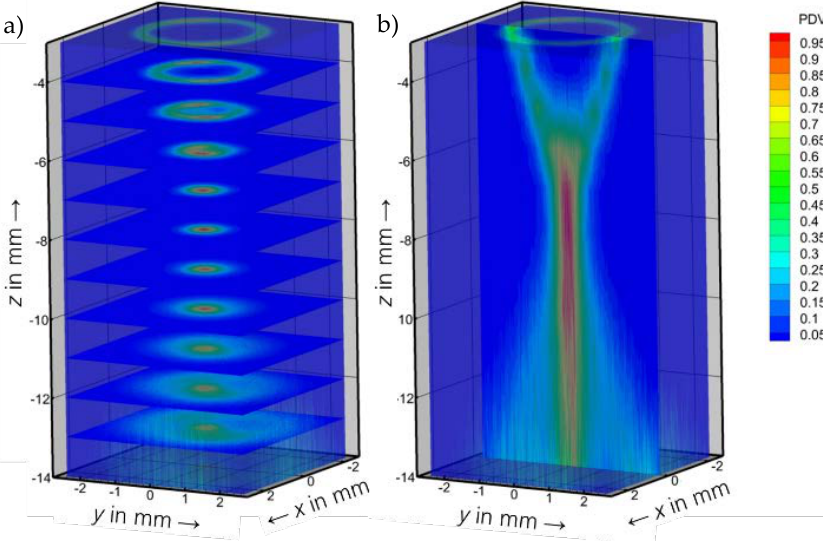
Figure 17. ( a ) level-wise probability density as a function of the working distance 7 = const., ( b ) level by level probability density as a function of the working distance for × = const. Parameters: grain fraction -53 + 20 µm, = 15 g/min, V FG = 5 L/min [1]. Reprinted with permission from Ref [1]. Copyright 2020, Fraunhofer Verlag. 𝑚𝑚̇ 𝑝𝑝